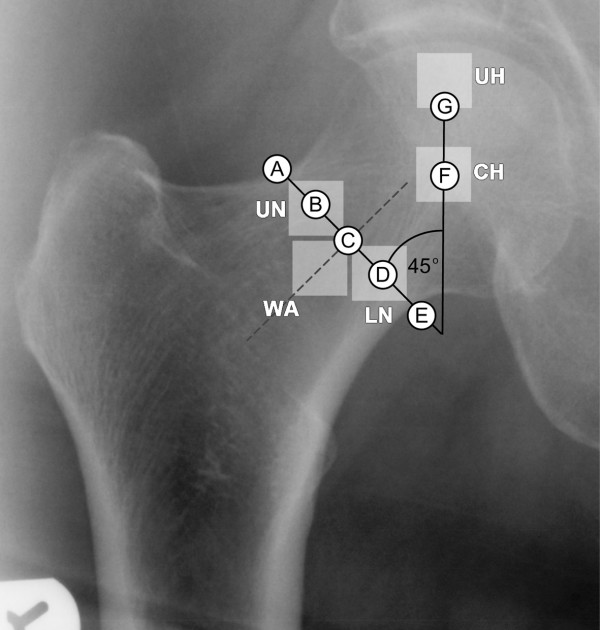
Regions of interest. Displays the five regions of interest, upper femoral head (UH), central femoral head (CH), upper femoral neck (UN), Ward's triangle area (WA) and the lower femoral neck (LN) used for analysis. Points A to G are determined by the femoral head and neck and used to locate the ROIs. Points A and E mark the femoral neck width. Points B, C and D lie at 1/4, 1/2 and 3/4 along this line. Point F is the centre point of the femoral head, point G at 1/2 the radius of the femoral head at an angle of 45 degrees to the neck width, 135 degrees to the neck shaft, shown as a dashed line through point C.